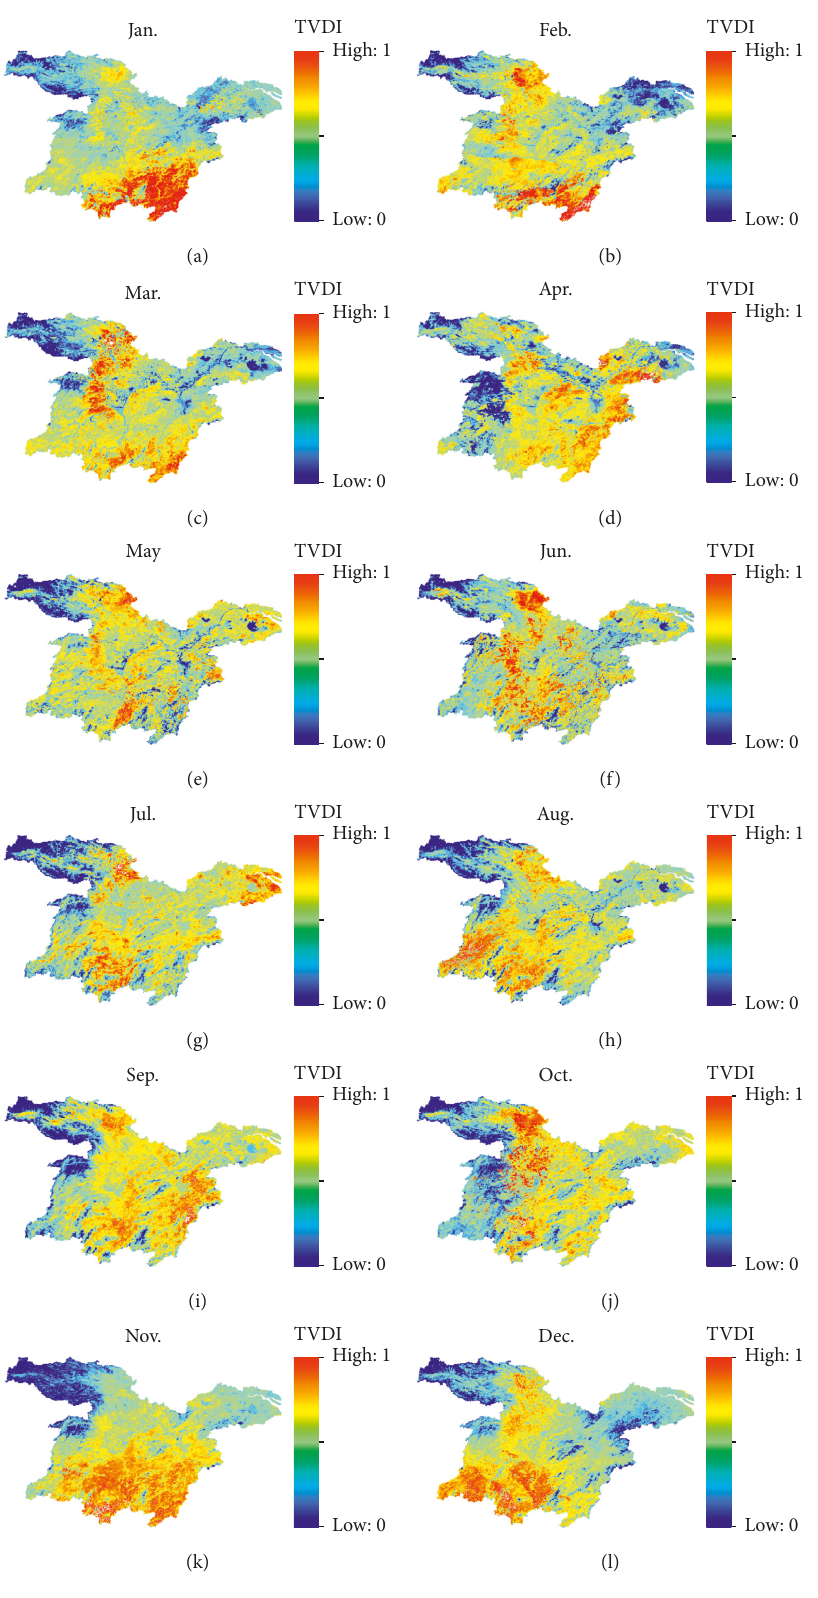
Figure 5: Distribution of drought conditions in the MLRYRB as assessed using the TVDI from January to December in 2013. (a) Jan. (b) Feb. (c) Mar. (d) Apr. (e) May. (f) Jun. (g) Jul. (h) Aug. (i) Sep. (j) Oct. (k) Nov. (l)